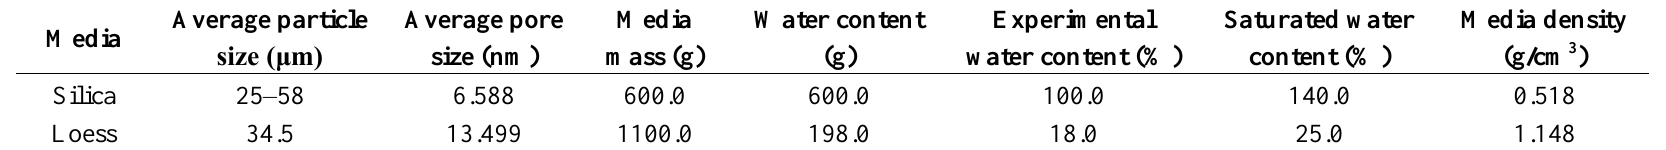
Table 1. Physical properties of the experimental media.